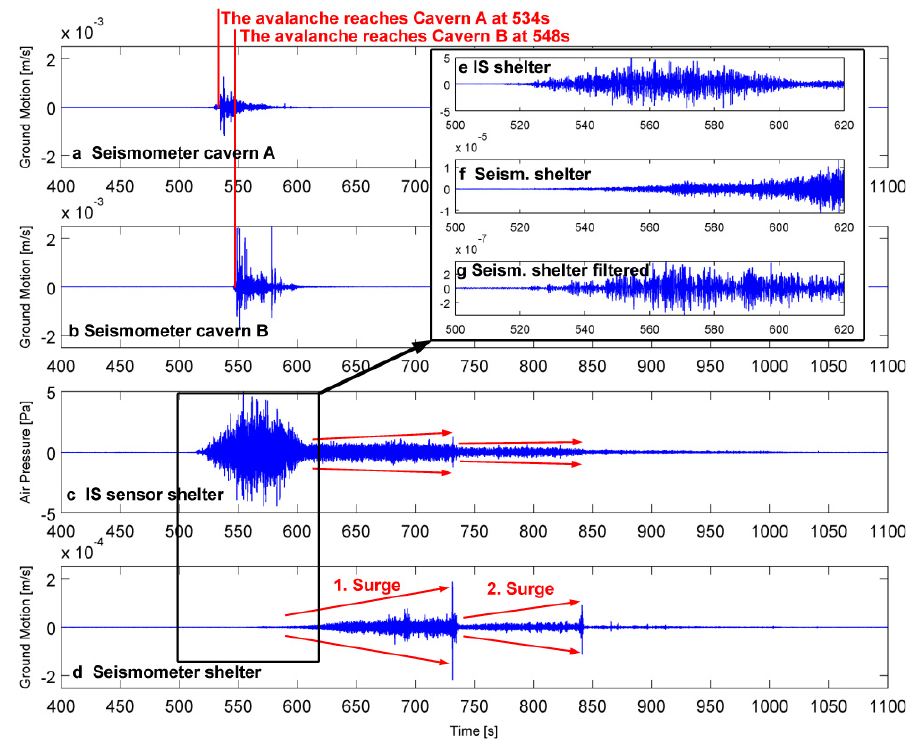
Fig. 6. Seismic (N-S component) and infrasonic data from Avalanche 1. Signals are represented with a common base of time. (a) Seismogram in cavern A; (b) Seismogram in cavern B; (c) infrasound time series near the shelter; (d) Seismogram near the shelter; (e) magnified infrasound time series; (f) magnified Seismogram near the shelter; and (g) magnified filtered (1–3Hz) Seismogram near the shelter. Red arrows indicate the infrasound signal associated with the different surges of the avalanche. Note the similar spindle shape between the seismic (g) and infrasound signals (e) . Magnified time series are shown with a different scale of amplitude and all series are plotted on an arbitrary time